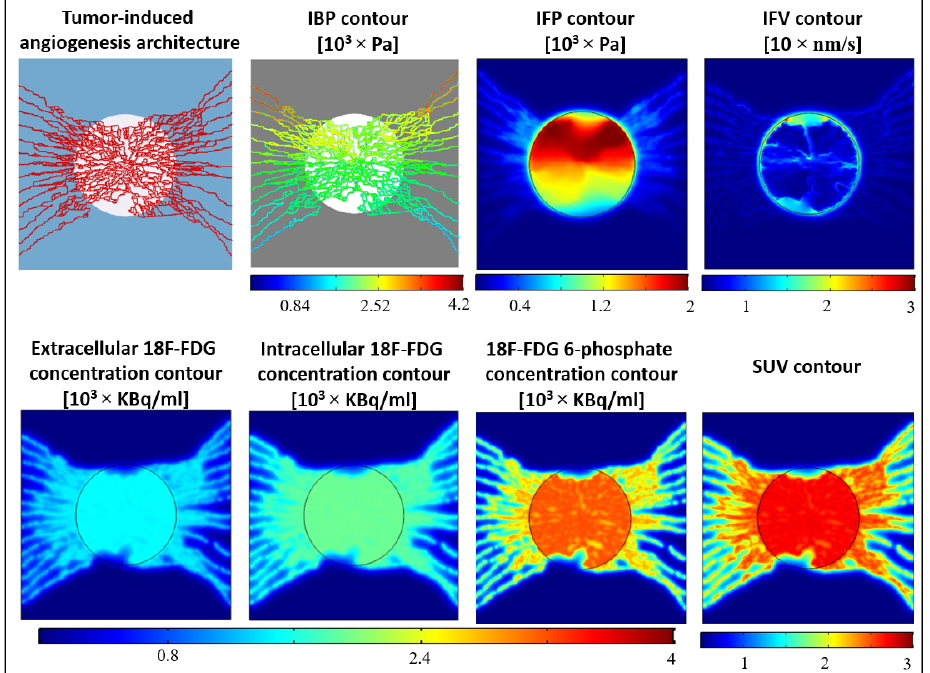
Figure 5. Results of biomathematical modeling in a tumor capillary network with 2.4 cm diameter; tumor-induced angiogenesis architecture, intravascular and interstitial fluid flow parameters, as well as local distribution of 18F-FDG radiotracer uptake in both tumor and healthy tissues one-hour post-injection.